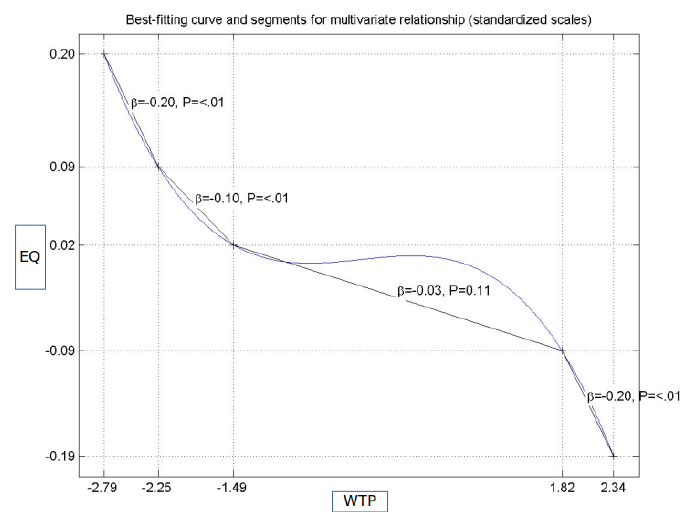
Figure 3. The non-linear relationship between the perception of overall quality and waiting time.